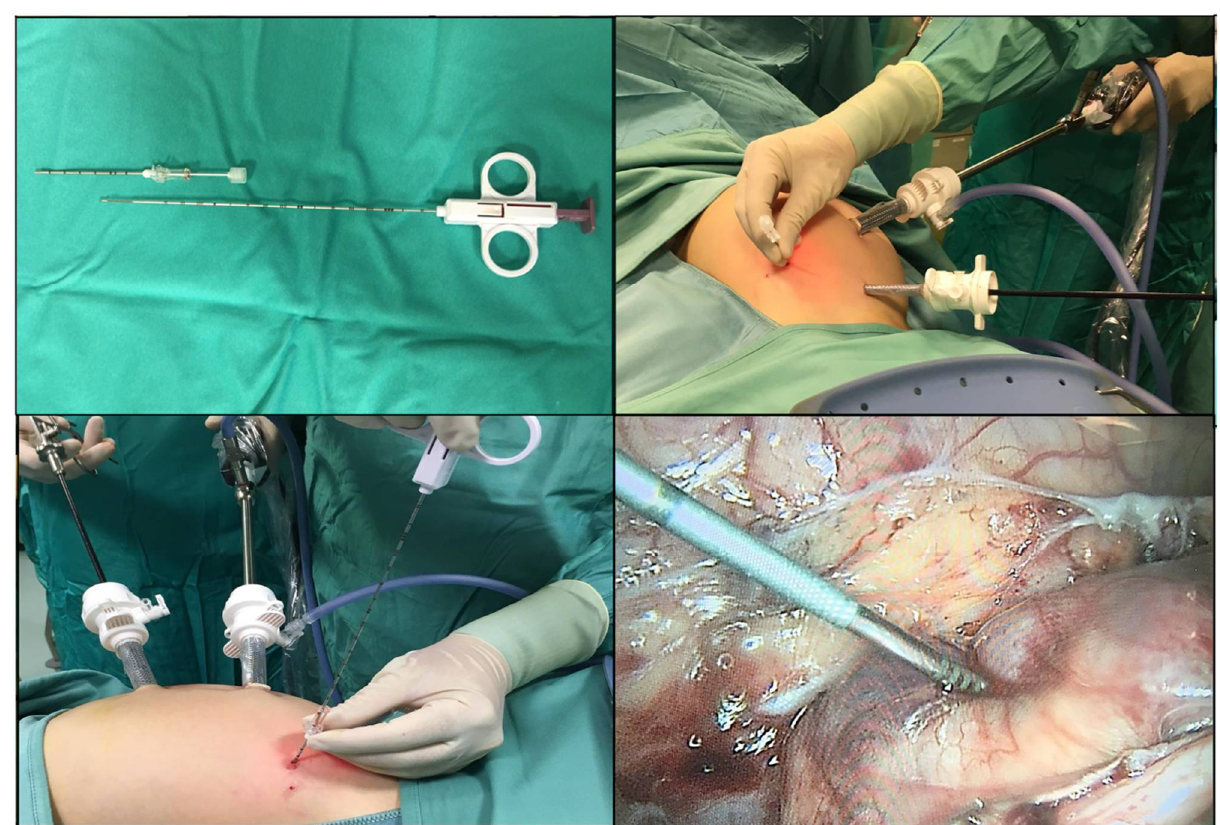
Figure 2. Laparoscopically assisted core needle biopsy (Group iv). Under laparoscopic vision, a mandrel is inserted through the abdominal wall into the tumor. Hence, the Stericut device is placed through the mandrel and the tumor biopsy is obtained. The procedure can be repeated several times and the position of the mandrel can be modified in order to sample multiple areas of the primary tumor. Then the tumor biopsy is collected sterile and placed in a test tube containing culture media.